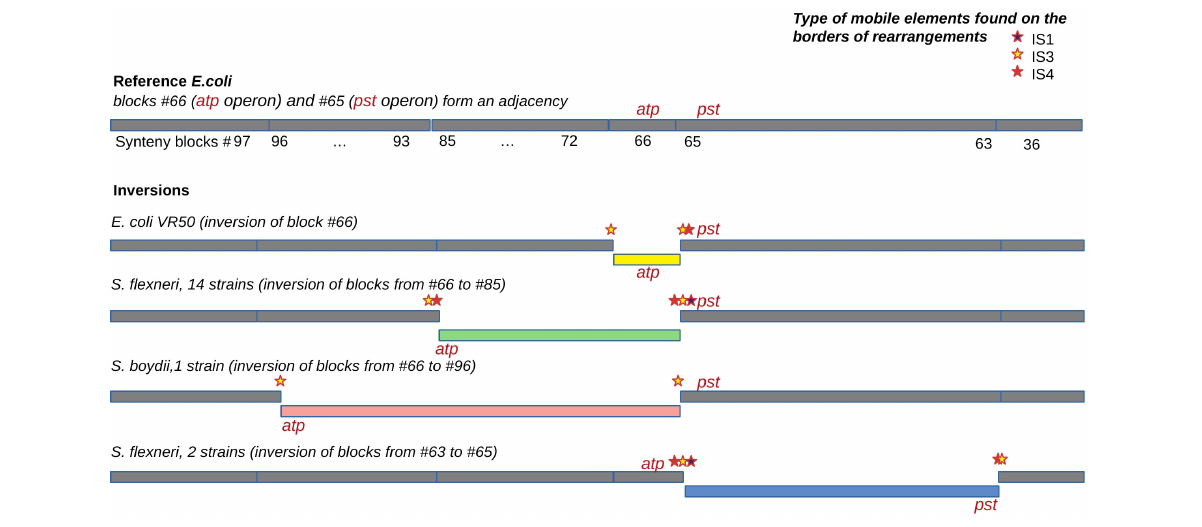
FIGURE 7 | An example of an independent disruption of the adjacency between synteny blocks #65 containing the pst operon (high-affinity phosphate transport system) and synteny blocks #66 containing the atp operon (proton-translocating ATPase) by four different inversions. IS families found in the adjacency and putatively responsible for the inversions are marked by coloured